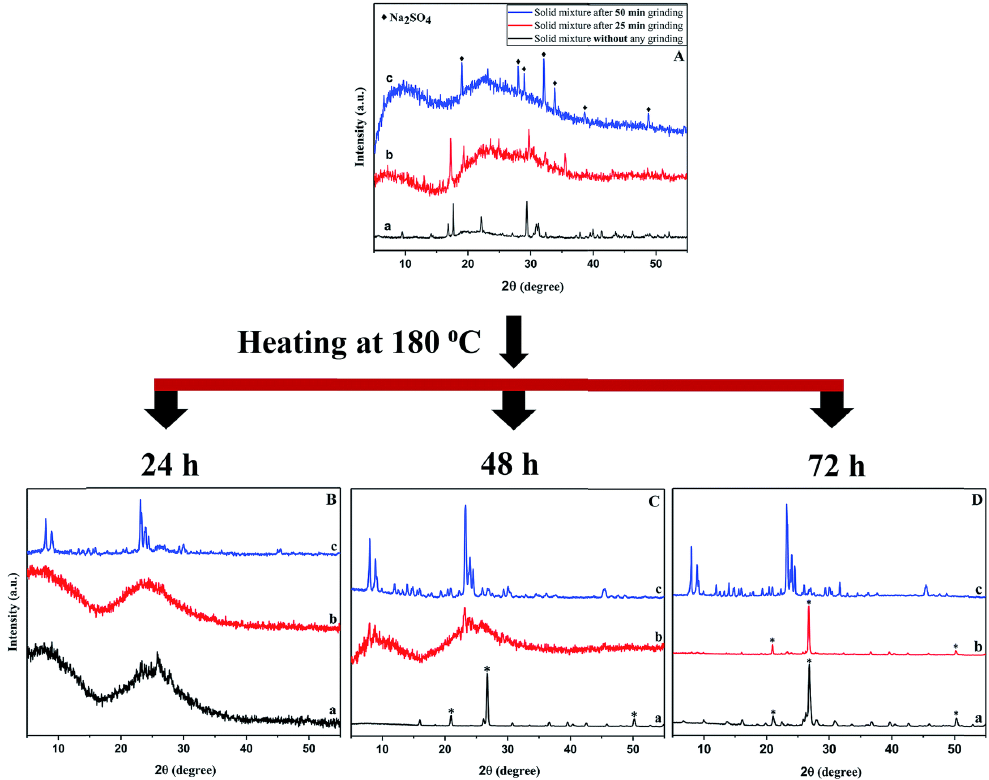
Figure 3. pXRD of as-synthesized MOR products resulting from mixtures of different grinding